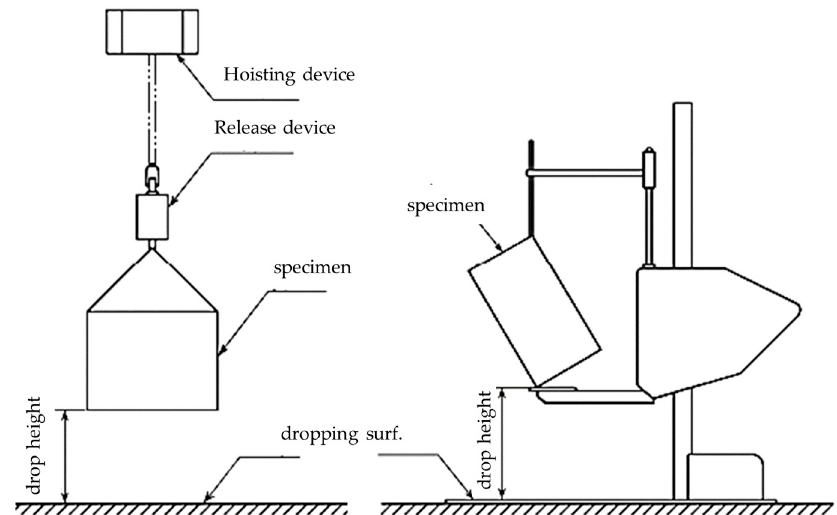
Figure 2. Drop-test apparatus [41].